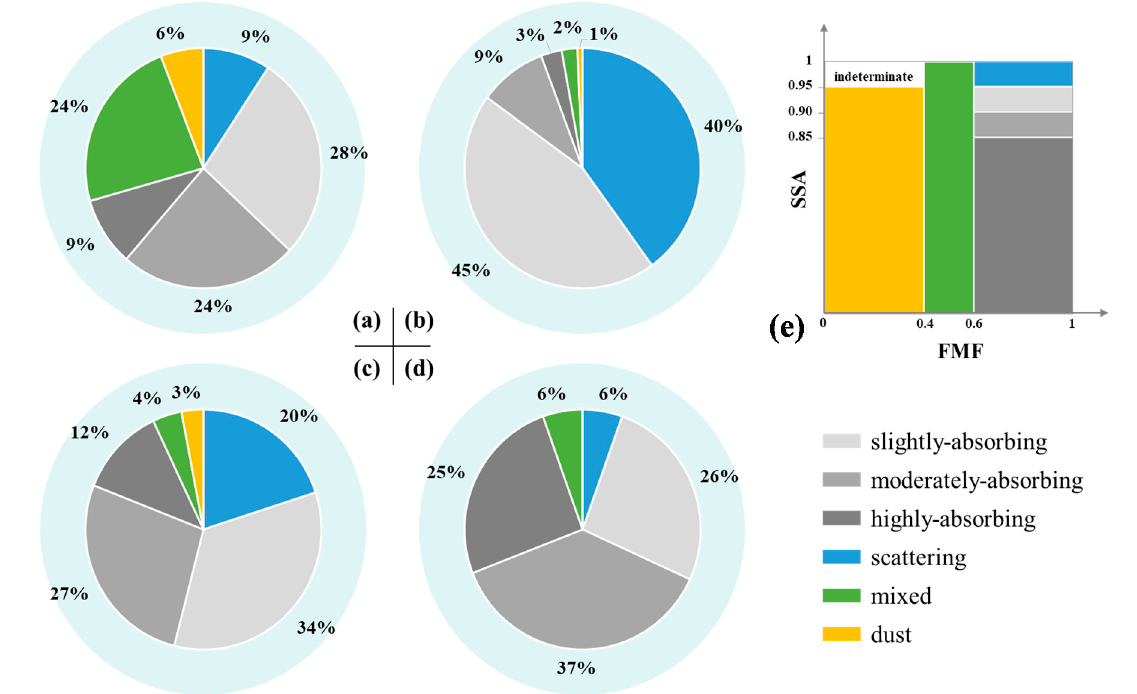
Figure 7. Average proportions of different aerosol types in ( a ) spring, ( b ) summer, ( c ) autumn, and ( d ) winter in Xi’an according to the aerosol classification scheme illustrated in ( e ), where aerosols can be grouped into six types according to different thresholds of their FMF and SSA.